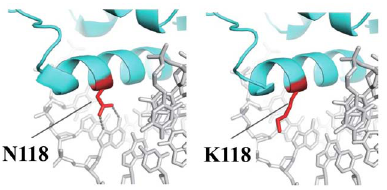
Figure 4. Insilico DNA binding analysis for c.354C . G (N118K) mutation. The structural change of the mutant protein and its effect on DNA binding was assessed using a FOXK2 protein. Hydrogen bonds (dot line) between DNA and the protein were predicted to be lost due to the N118K mutation. Green line: FOXK2 protein (Thick band indicates forkhead domain). Red line: 118th amino acid of FOXK2 protein and its side chains. Gray and white lines: DNA.